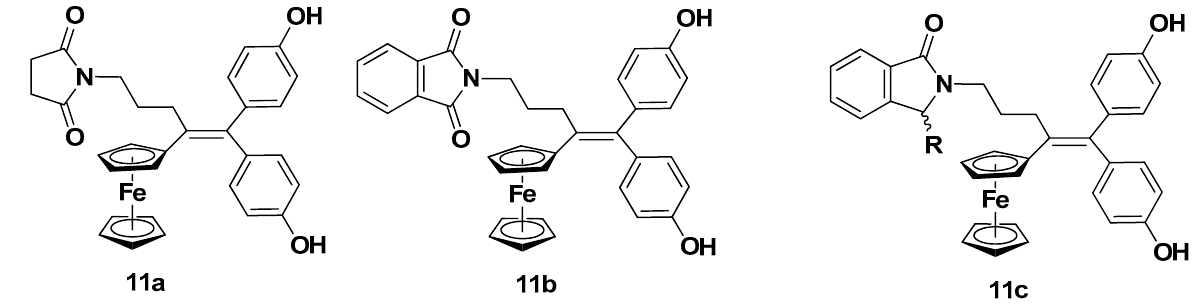
Figure 6. Ferrocene-modified tamoxifenes with succinimide ( 11a ), phthalimide ( 11b ), and other lactam substituents ( 11c ).